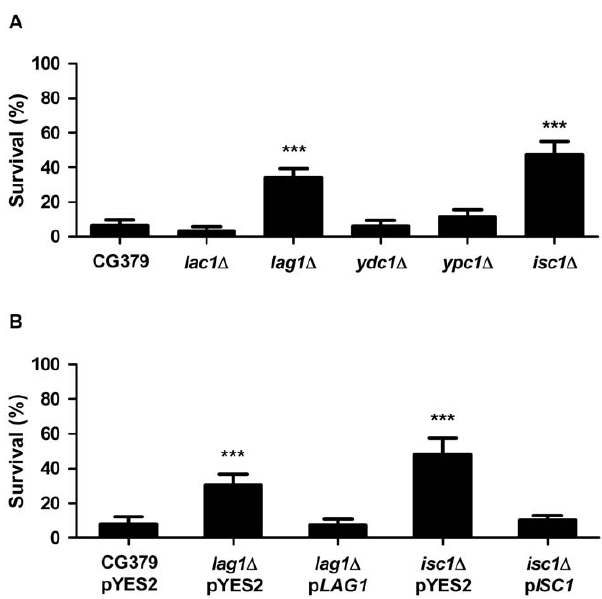
Figure 2. Acetic acid resistance in S.cerevisiae . (A) CG379 (wild- type), lac1 D , lag1 D , ydc1 D , ypc1 D and isc1 D strains, or (B) CG379 pYES2 (empty vector), lag1 D transformed with pYES2 or p LAG1 , and isc1 D transformed with pYES2 or p ISC 1. Cells were exposed to 180 mM acetic acid, pH 3.0, for 200 min. Cell viability was determined by standard dilution plate counts and expressed as a percentage of c.f.u on YPD plates. Values are mean 6 SD of at least three independent experiments. Values significantly different from CG379 strain: *** P , 0.001, One-way ANOVA and Tukey Test. (Figure S1A). Hydrogen peroxide was used as positive control, since there is a correlation between H 2 O 2 exposure and accumulation of carbonylated proteins [37,38]. In accordance with our previous results [6], overall levels of protein carbonylation in untreated and acetic acid-treated cells were similar, and much lower than those observed in cells treated with H 2 O 2 . However, cells treated with H 2 O 2 had the same total protein profile as untreated cells, whereas in cells treated with acetic acid there was an enrichment in three protein bands, while others were greatly decreased or disappeared altogether (Figure S1B). One explana-